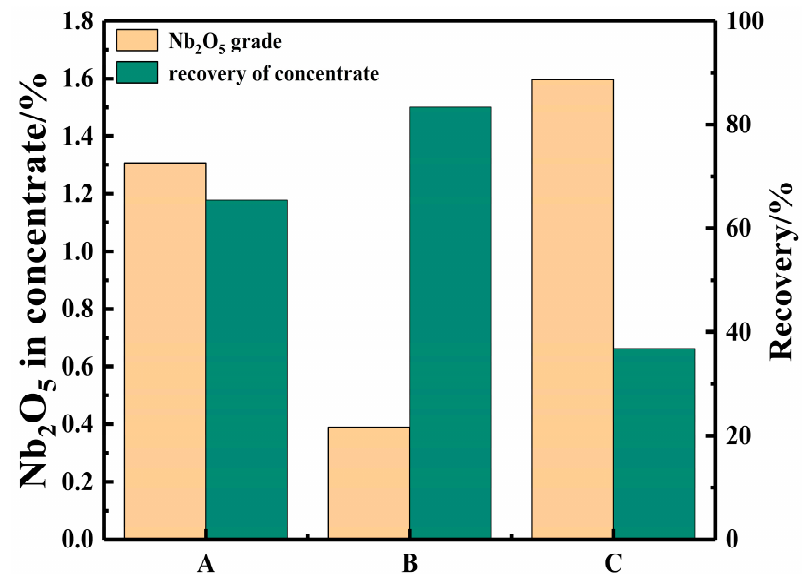
Figure 10. Comparison of flotation effects of three flotation collectors. (A: HOBA; B: octyl isohydroxamic acid; C: salicylic hydroxamic acid).